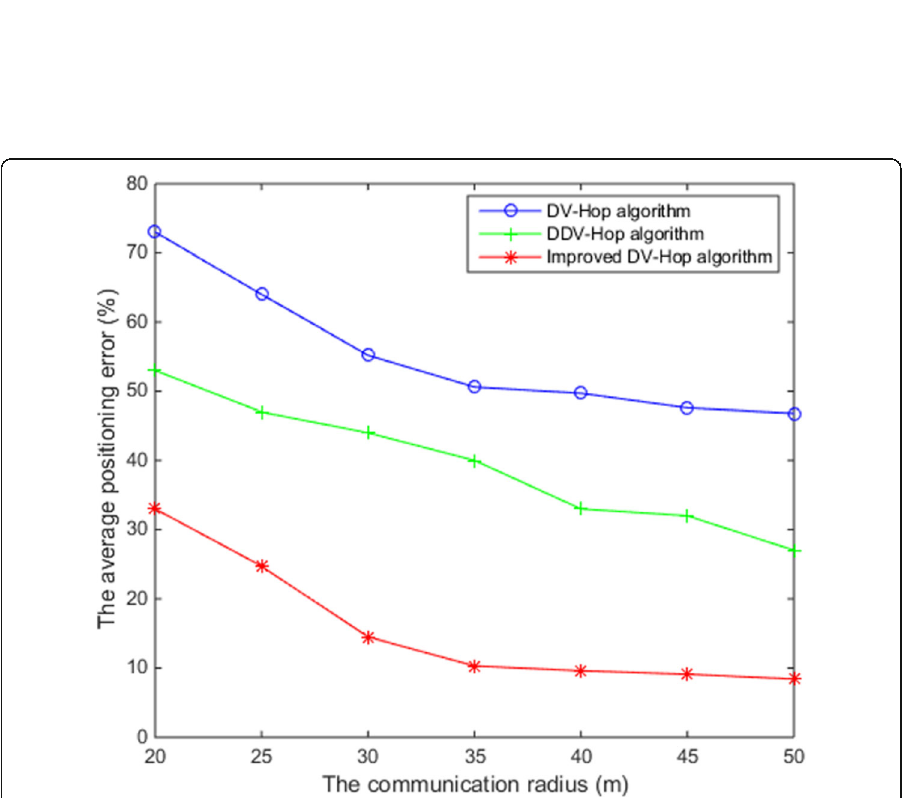
Fig. 9 The influence of communication radius change on positioning